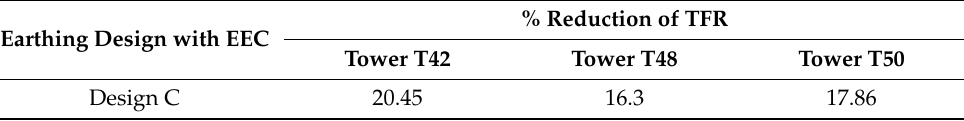
Table 7. Percentage reduction of TFR for selected